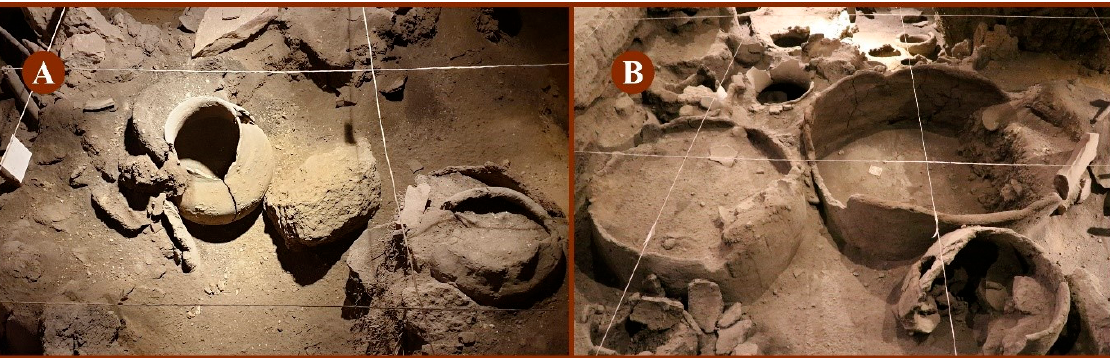
Figure 2. Wine production facility in Areni-1 cave complex. ( A ) small clay jar (“karas”) and ( B ) clay storage constructions. Photo credit: M. Harutyunyan.